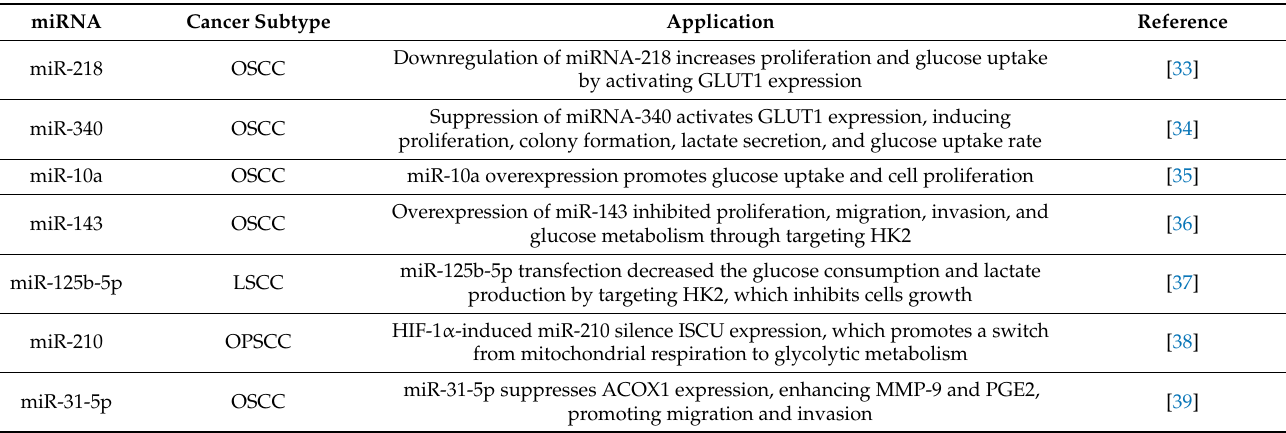
Table 1. miRNAs involved in HNSCC